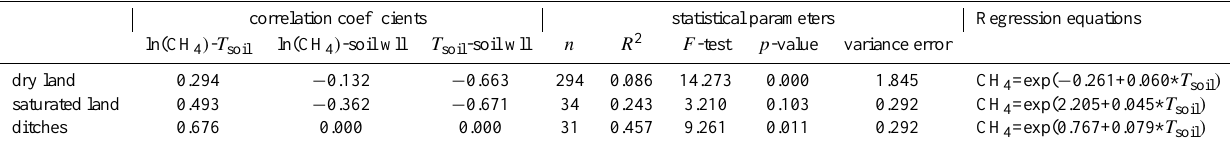
Table 6. Regression analyses of relations between CH 4 fluxes, soil temperature and water level for relatively dry land, saturated land and ditches. From left to right the correlation coefficients, amount of samples ( n ) goodness-of-fit of the correlation ( R 2 ) , F -test with significance ( p -value) and variance error as well as the regression equation for CH 4 with soil temperature are shown. correlation coefficients statistical